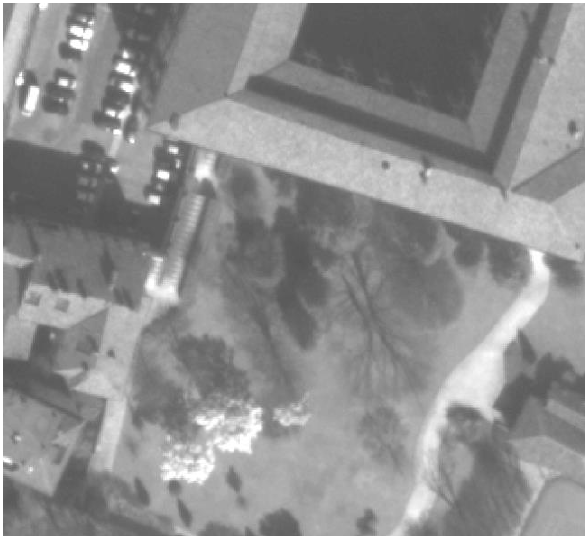
Figure 2. Lower right portion of the entire scene.